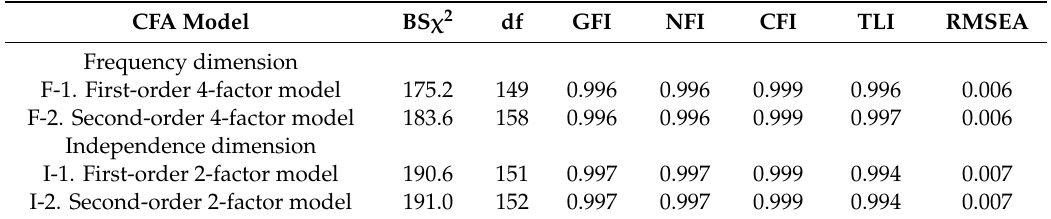
Table 5. Model fit indices for the frequency and independence dimensions of FUNDES-Child 1 by confirmatory factor analyses ( n =